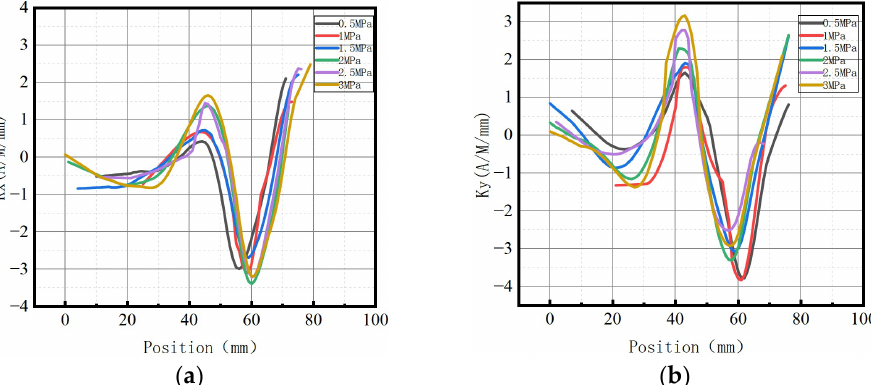
Figure 27. Variations of the magnetic field strength gradient K at the weld under different internal pressures. ( a ) The axial gradient component Kx; ( b ) the radial gradient component Ky.